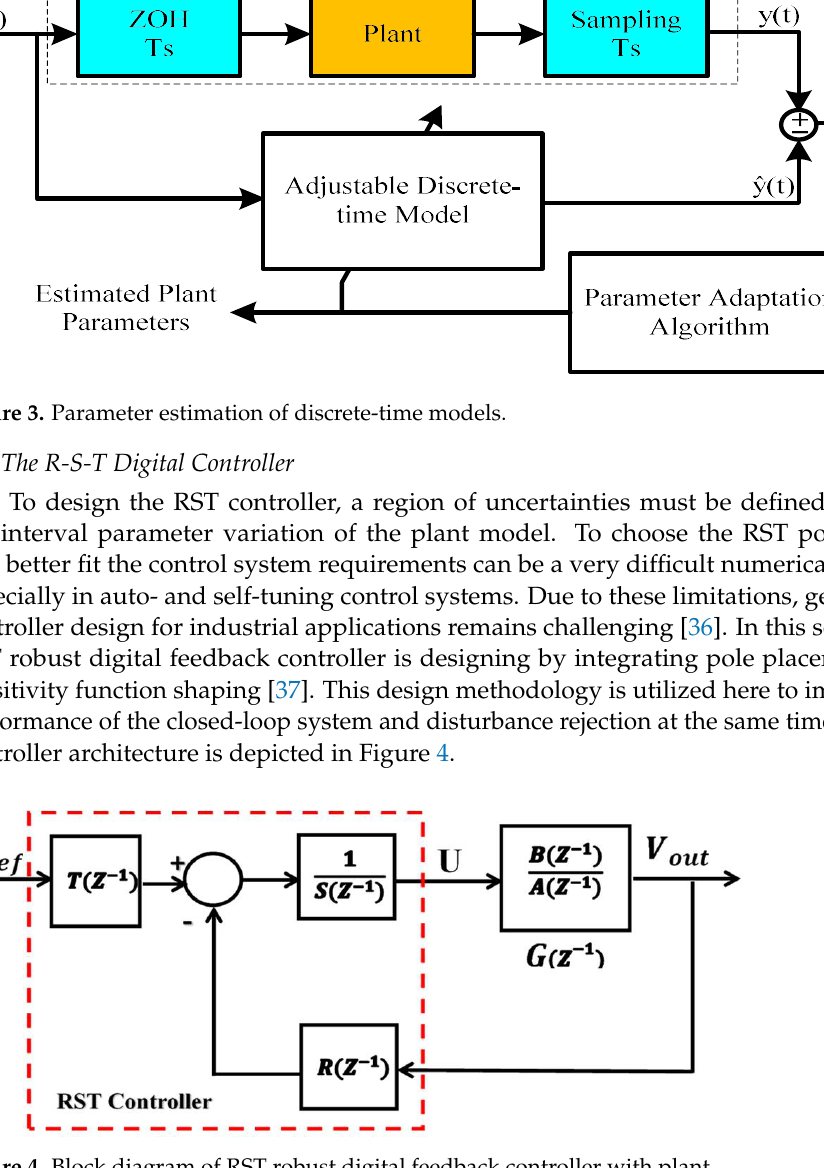
Figure 4. Block diagram of RST robust digital feedback controller with plant.